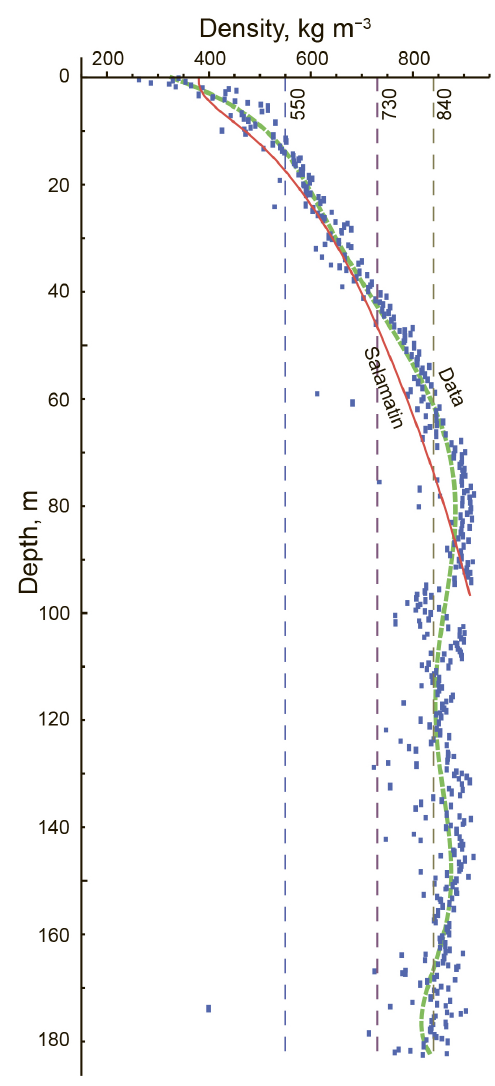
Figure 5. Measured (blue dots) and simulated (red line) ice-core density profile with critical densities shown as dashed lines (see Sect. 3.3.2). The green dashed line is a running mean for the mea- sured density